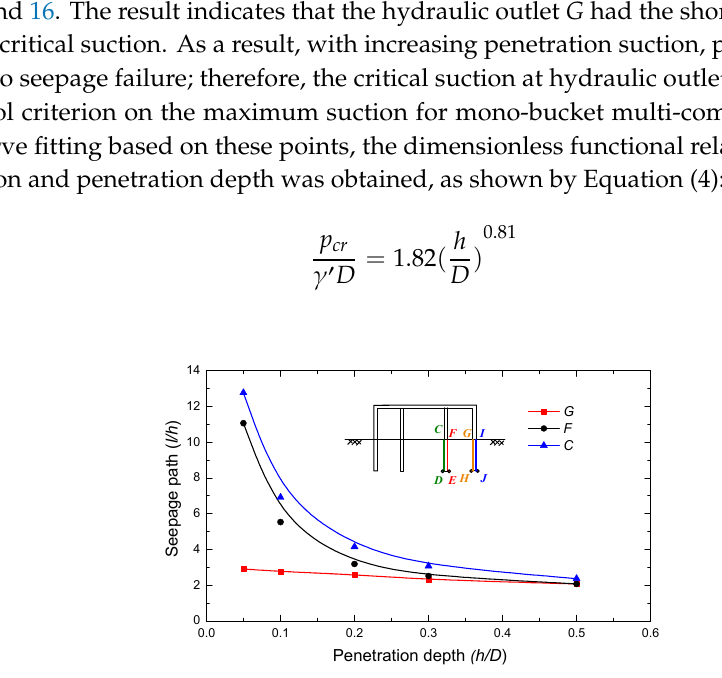
Figure 14. Relationship between the critical suction and penetration depth.